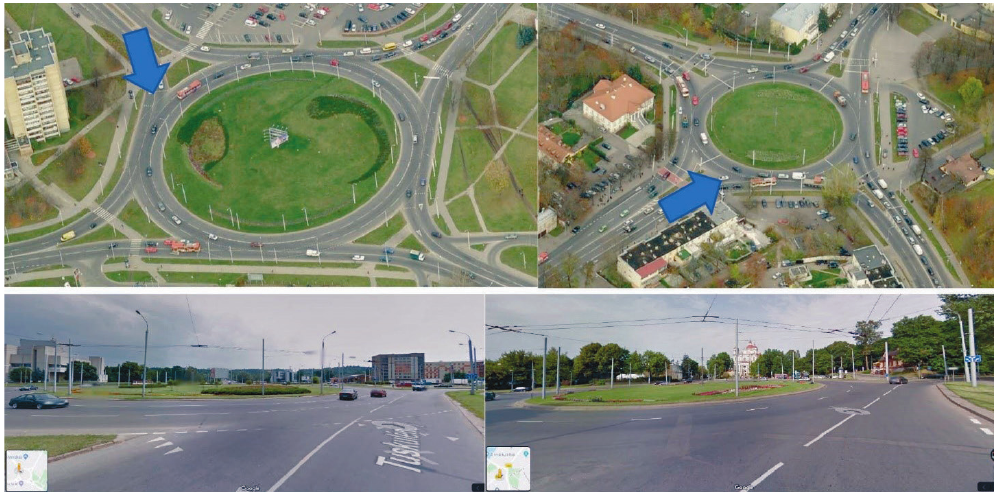
Figure 3. Aerial and local view at roundabouts before traffic reorganisation (arrow in aerial view shows direction of local view, “Žirmūnai Roundabout” on the left side and “Olandai Roundabout” on the right